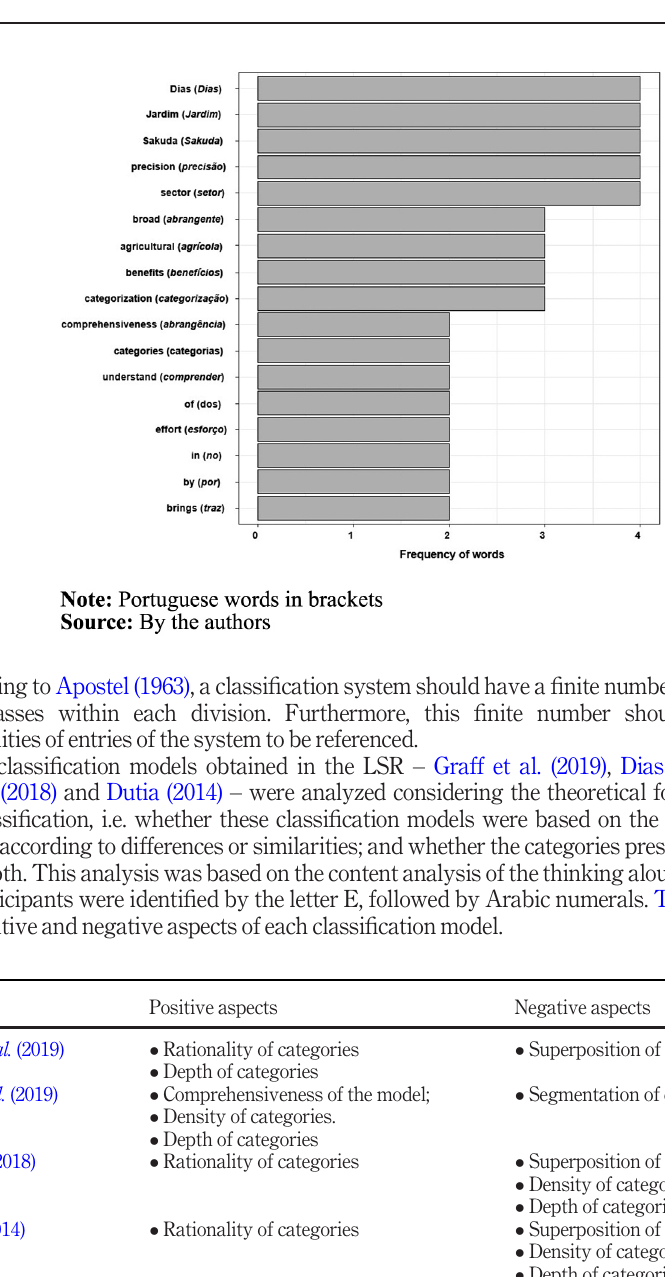
Table 2. Positive and negative aspects of each agtech classi fi cation